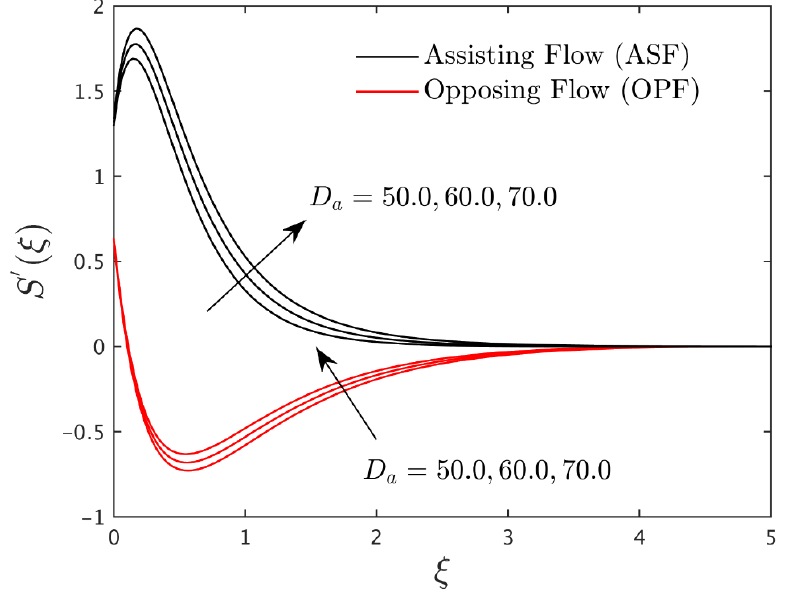
Figure 2. Velocity profile for the case of ASF and OPF due to variations in the values of D a .